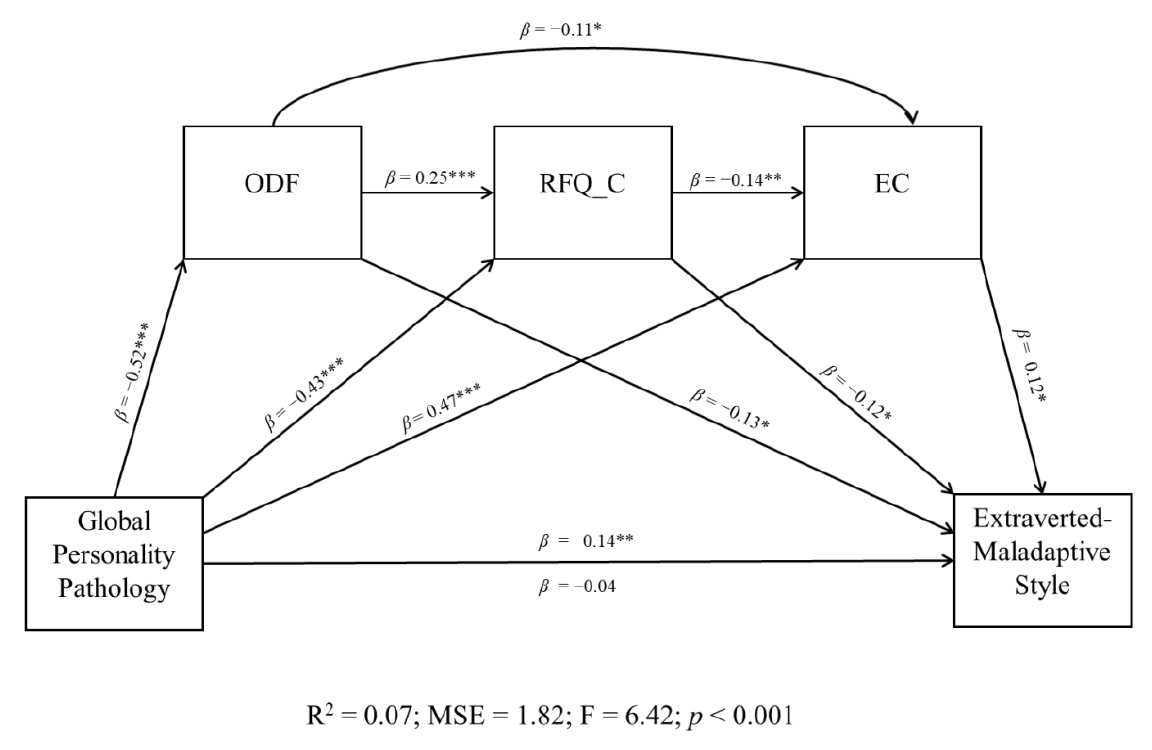
Figure 2. A Sequential Mediation Model Examining the Direct and Indirect Effects of Global Per- sonality Pathology on Extraverted-Maladaptive Response Pattern to the COVID Pandemic and its Mitigation Strategies. Note. ODF = Overall Defensive Functioning; RFQ_C = Certainty About Mental States; EC = Epistemic Credulity. β = Standardized Beta Coefficient ; R 2 = R-squared; MSE = Mean Squared Error; F = F-distribution. * p ≤ 0.05. ** p ≤ 0.01. *** p ≤ 0.001.